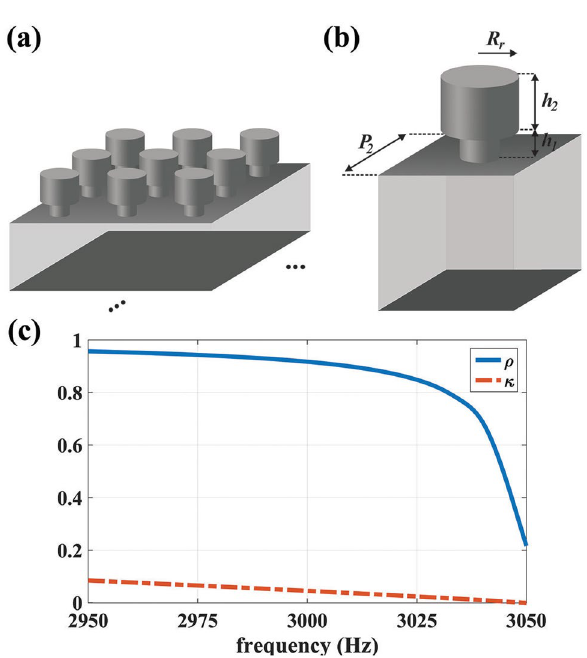
Figure 8. ( a ) The two dimensional schematic of Helmholtz resonator metamaterials. ( b ) The structural demonstrations of the realized unit cell with the parameters of P 2 R r 1.5 mm. ( c ) The retrieved relative mass density and bulk modulus extracted from full-wave =